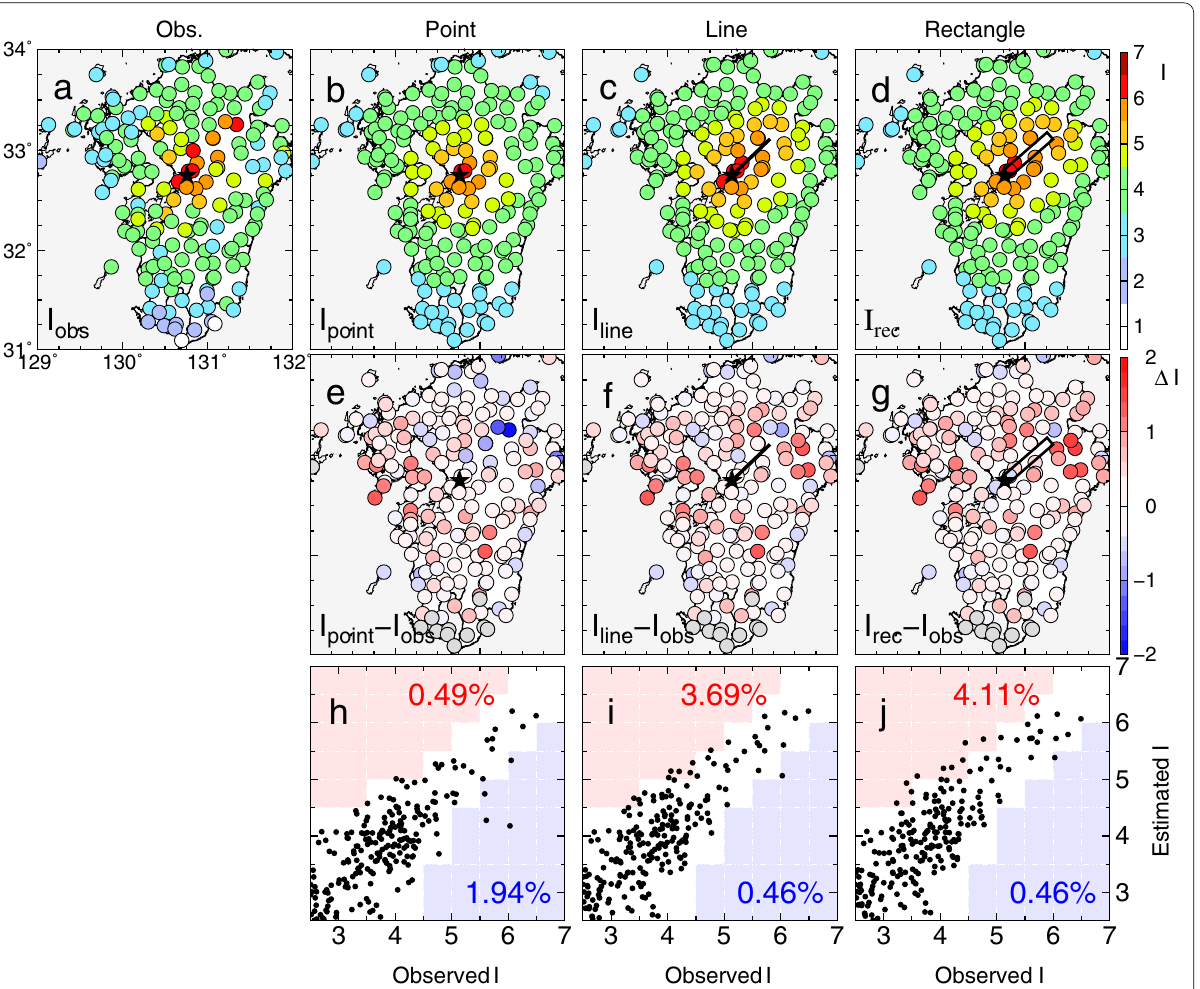
Fig. 14 Distribution of the seismic intensity and the differences at 100 s for the 2016 Kumamoto earthquake. The observation and estimations of the point-source, line-source, and rectangle-source models are shown in the left column. The format is the same as in Fig.